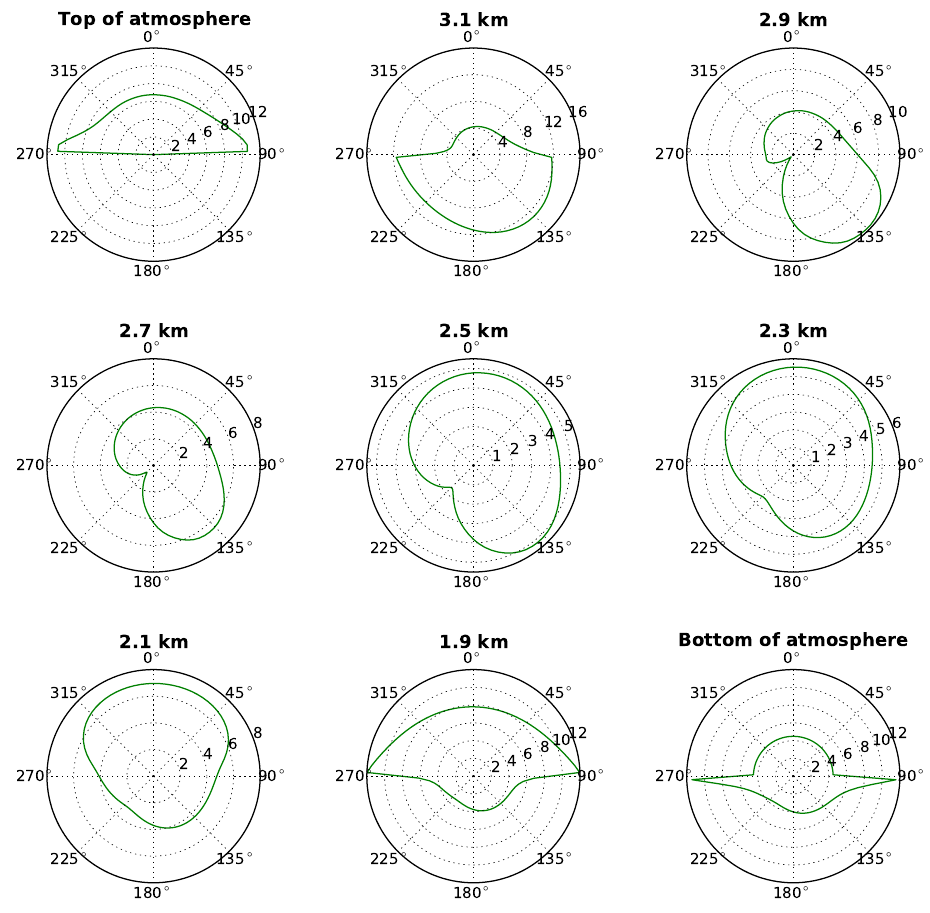
Fig. 8. The filling-in factor [%] in the principal plane for various altitudes. The polar angle gives the direction of the radiation. Calculated from the radiances in Fig. 7. Note that the scales on the various plots